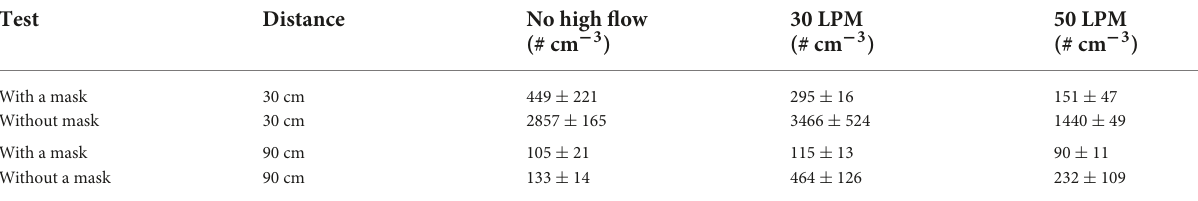
With a mask Without a mask TABLE 2 The max PNC of each run; mean and standard deviations over the three